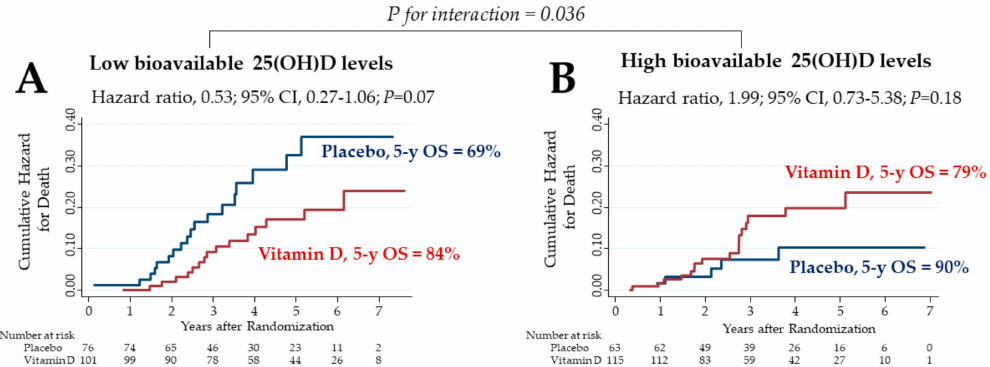
Figure 3. Nelson–Aalen cumulative hazard curves for death in the subgroups of bioavailable 25(OH)D levels lower ( A ) and higher ( B ) than median levels (1.71 ng / mL) before starting supplementation. 25(OH)D: 25-hydroxyvitamin D; CI: confidence interval; 5 y OS: 5 year overall survival.